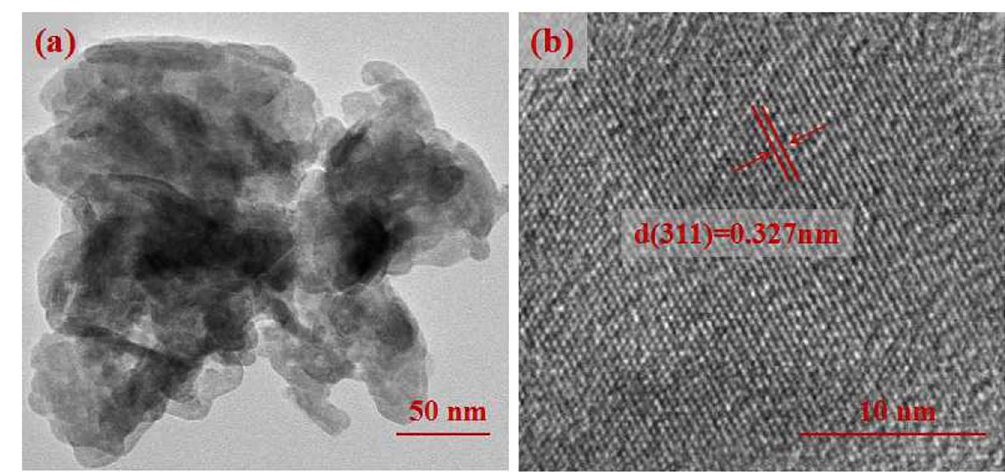
Figure 6. TEM ( a ) and HR-TEM images ( b ) of CdIn 2 S 4 nano-petals synthesized at 160 °C for 12